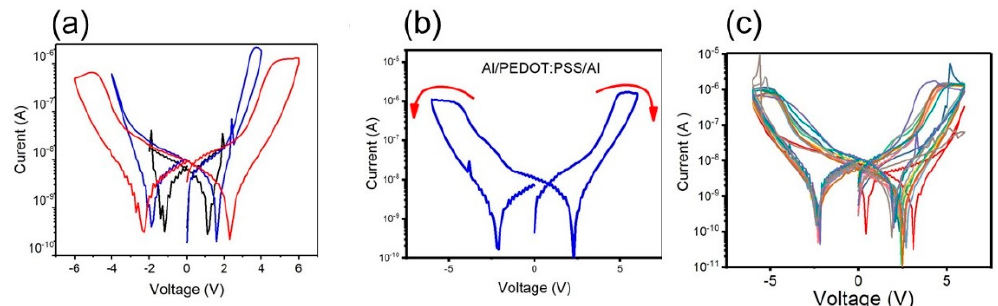
Figure 3. ( a ) Current–voltage (I–V) characteristic of three consecutive cycles of Al/PEDOT:PSS/Al memory elements; ( b ) I–V characteristics of one of the switched devices; ( c ) I–V characteristics of the 13 tested devices.